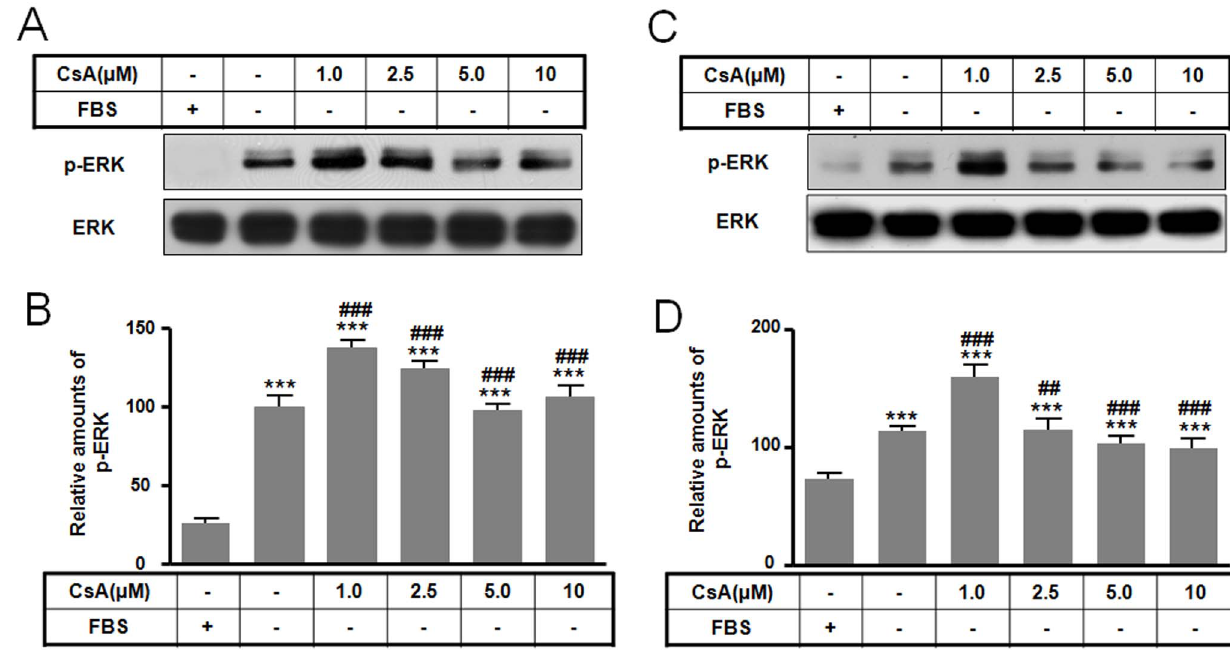
Figure 3. Effect of CsA-mediated autophagic and apoptotic cell death on p-ERK levels. GH3 cells were incubated in DMEM with or without 10% fetal bovine serum in the presence or absence of CsA (0 to 10 m M) for 10 h. Levels of p-ERK for autophagy (A) and apoptosis (C) were determined by Western blotting and the relative amount of p-ERK for autophagy (B) and apoptosis (D) was calculated as described in the Materials and Methods. *** p , 0.01 vs. serum treatment. ## p , 0.01, ### p , 0.001 vs. no serum